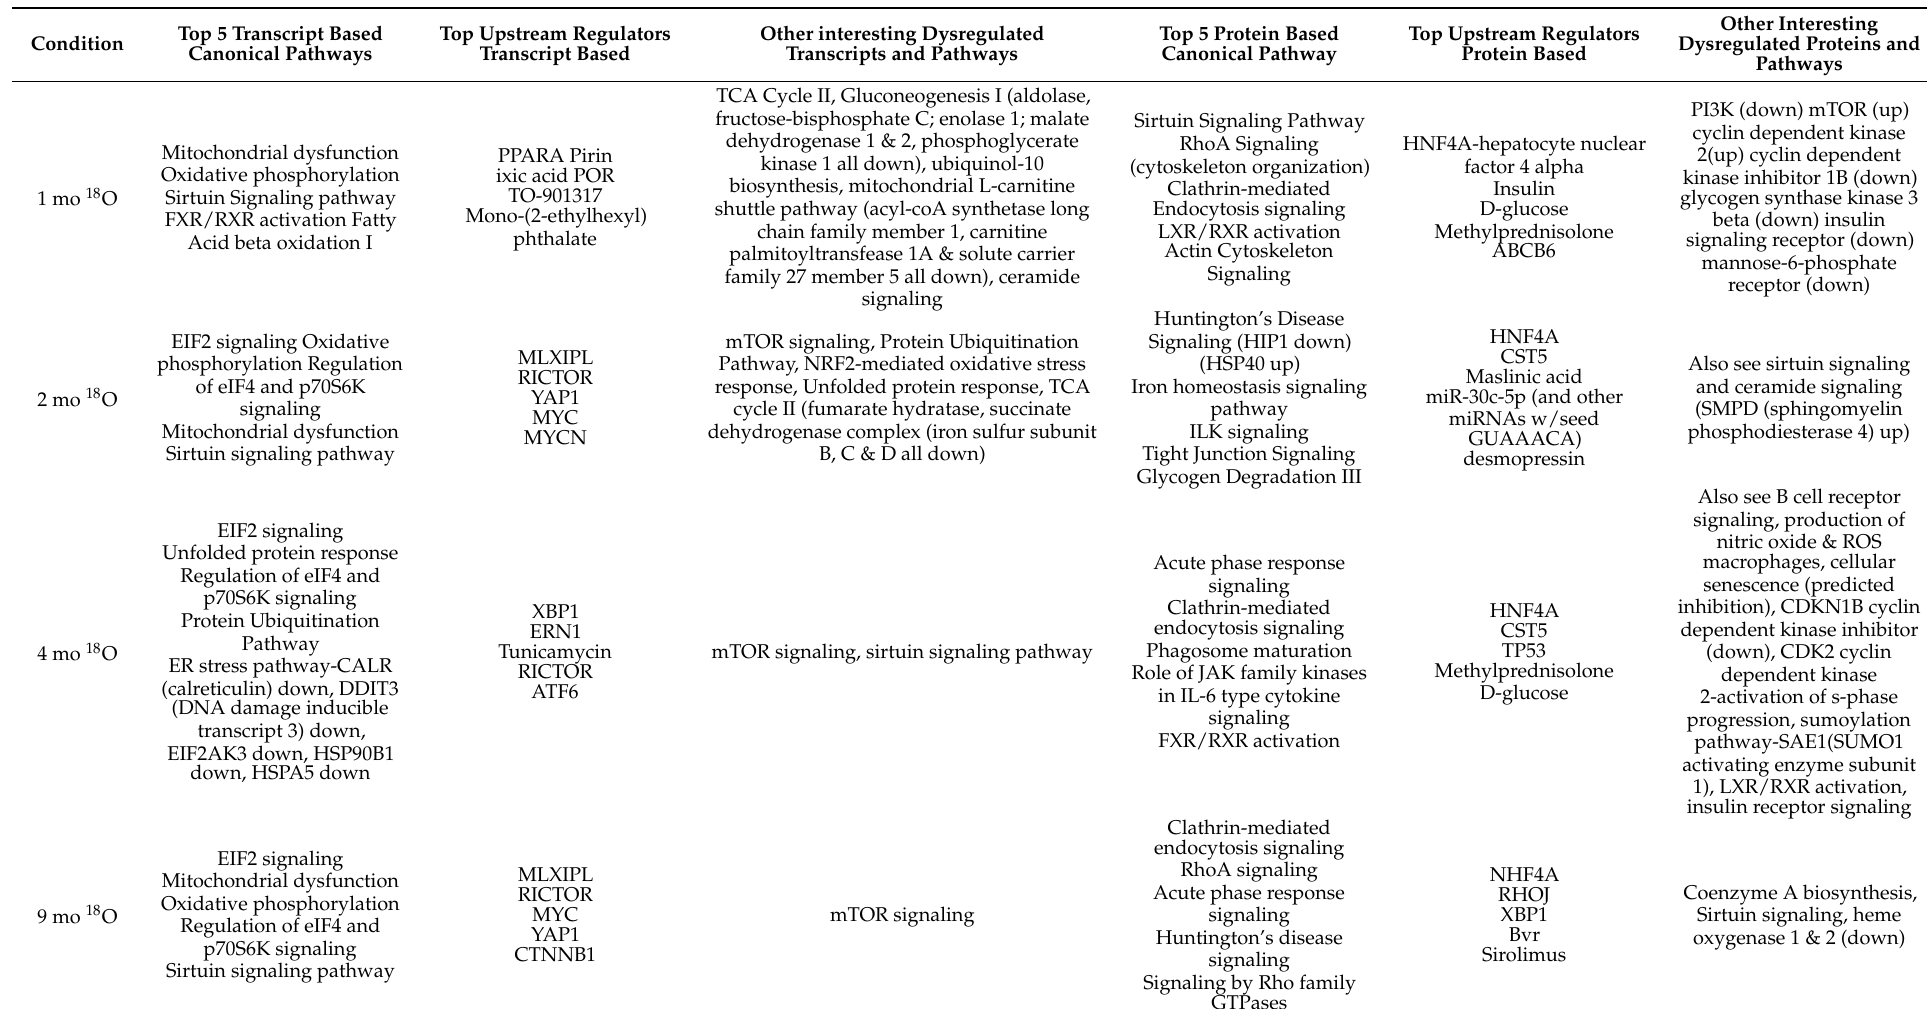
Table 2. Pathways Effected in Each Condition Based on Transcripts and